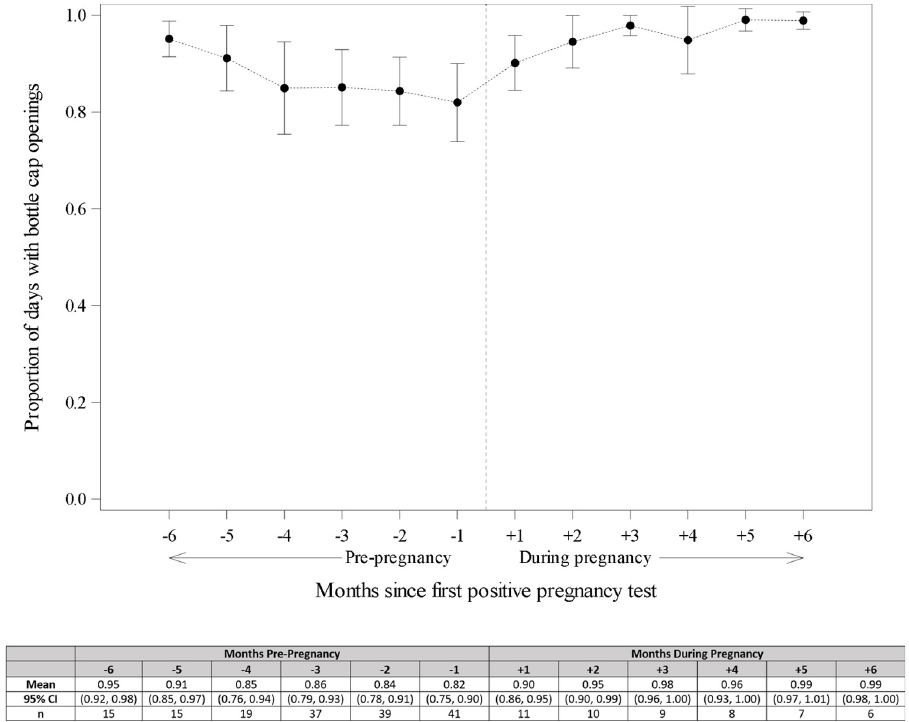
Fig 5. Adherence prior to and post-pregnancy among those women with incident